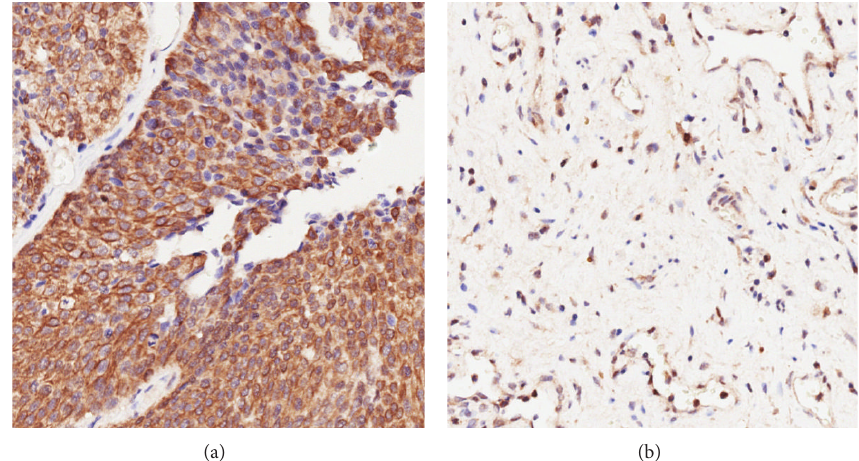
Figure 6: Immunohistochemistry of the tissue location analysis of expression products of gene HSP74 showed that they are distributed positively in bladder cancer tissues (a) and negatively in bladder cancer adjacent normal tissues (b) ×